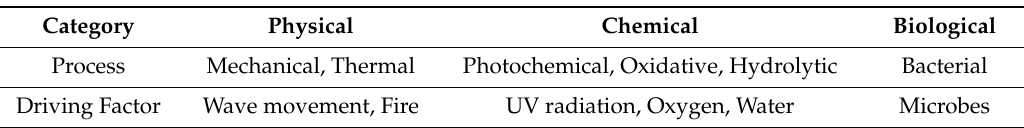
Table 2. Decomposition processes for degradation and fragmentation from macro- to microplastic (according to [194] and [43]).